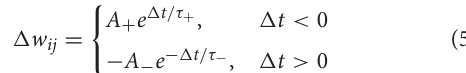
cortex is the regular spiking (RS) pattern with the parameters a = 0.01, b = 0.2, c = − 65, and d = 8. While the inhibitory cells always exhibit fast spiking (FS) pattern with the parameters a = 0.1, b = 0.2, c = − 65, and d =